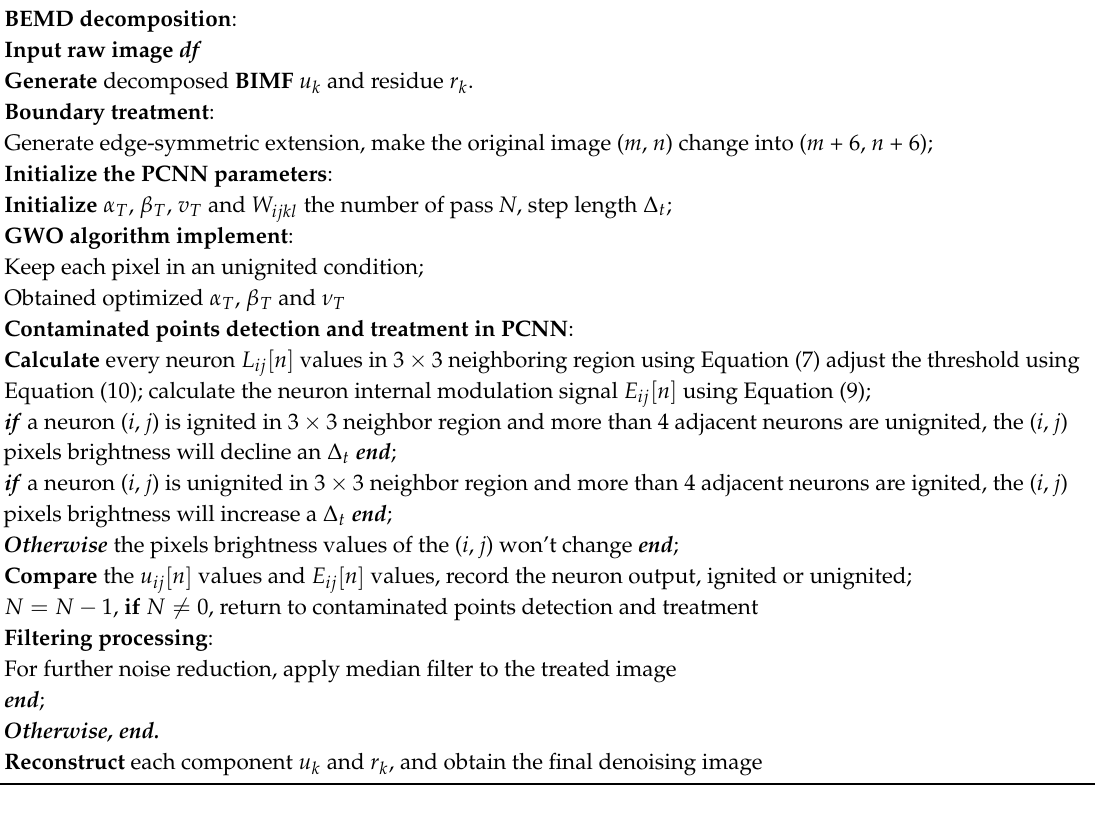
Algorithm 3 The Adaptive PCNN Optimized by the GWO and BEMD Algorithm BEMD decomposition : Input raw image